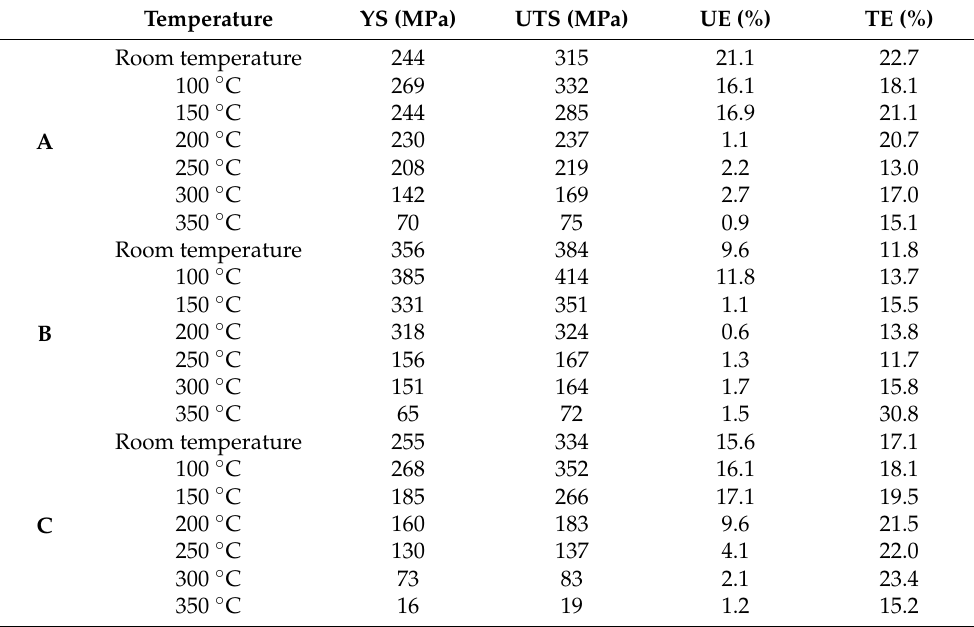
Table 5. Average high-temperature tensile properties and hardness of SLM Al–Mg–Sc–Zr